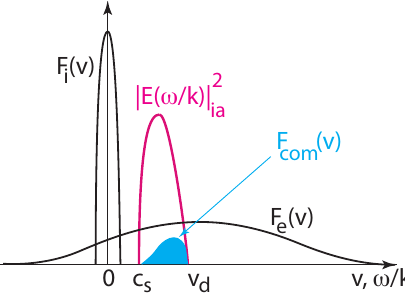
Figure 2. Phase space of ion-acoustic waves excited by the ion- acoustic instability. Shown are the one-dimensional background ion F i (v) and electron F e (v) distributions. Ion-acoustic wave with spec- trum | E(ω/k) | 2 evolve at phase velocities above the minimum ia of c ia in the range c s < ω/k < v d . The electron pair distribution function F com (v) produced in the high-phase speed range is shown schematically in blue. One may note the very low velocity spread of the pair distribution indicating the much lower pair than original electron background temperature T pair (cid:28) T e .